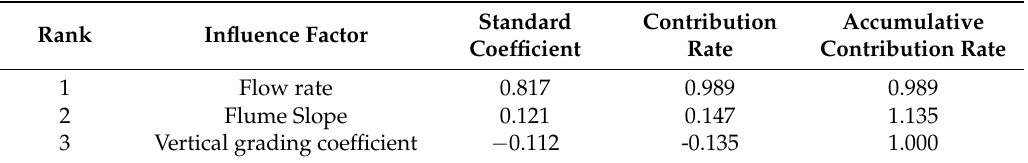
Table 3. Contribution rates of experimental factors on average flow